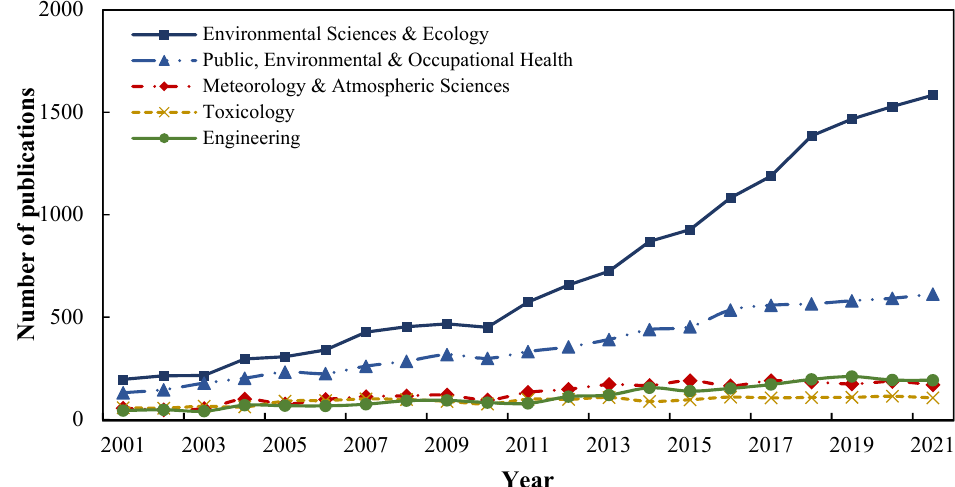
Figure 4. The top 5 research areas of publications.